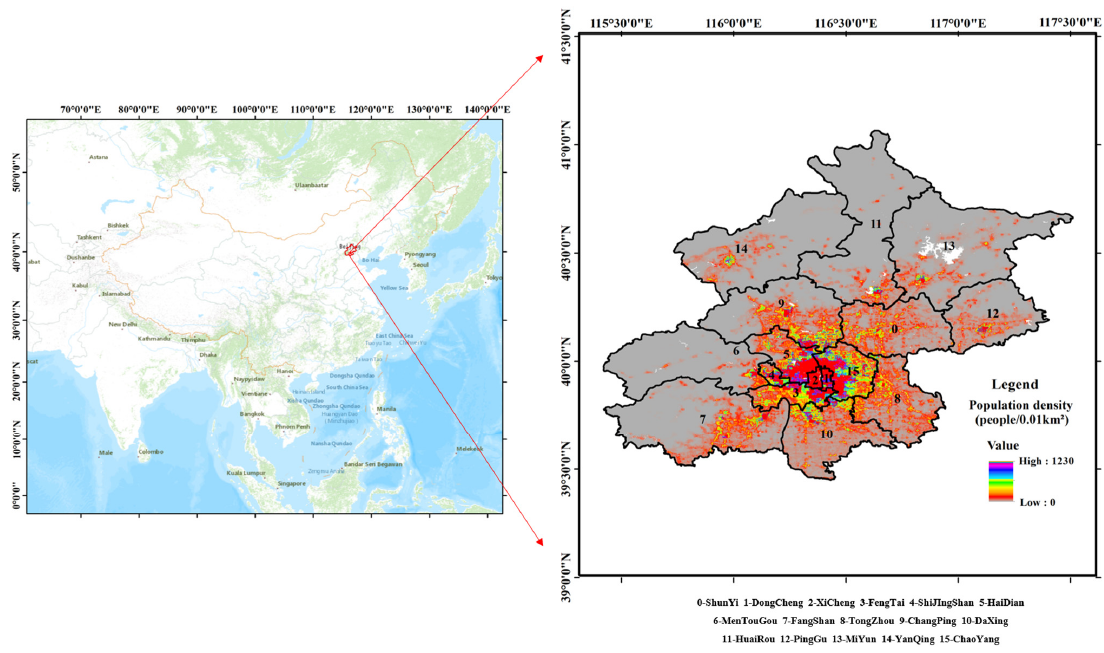
Figure 1. Regional division and population density distribution of Beijing in 2020.